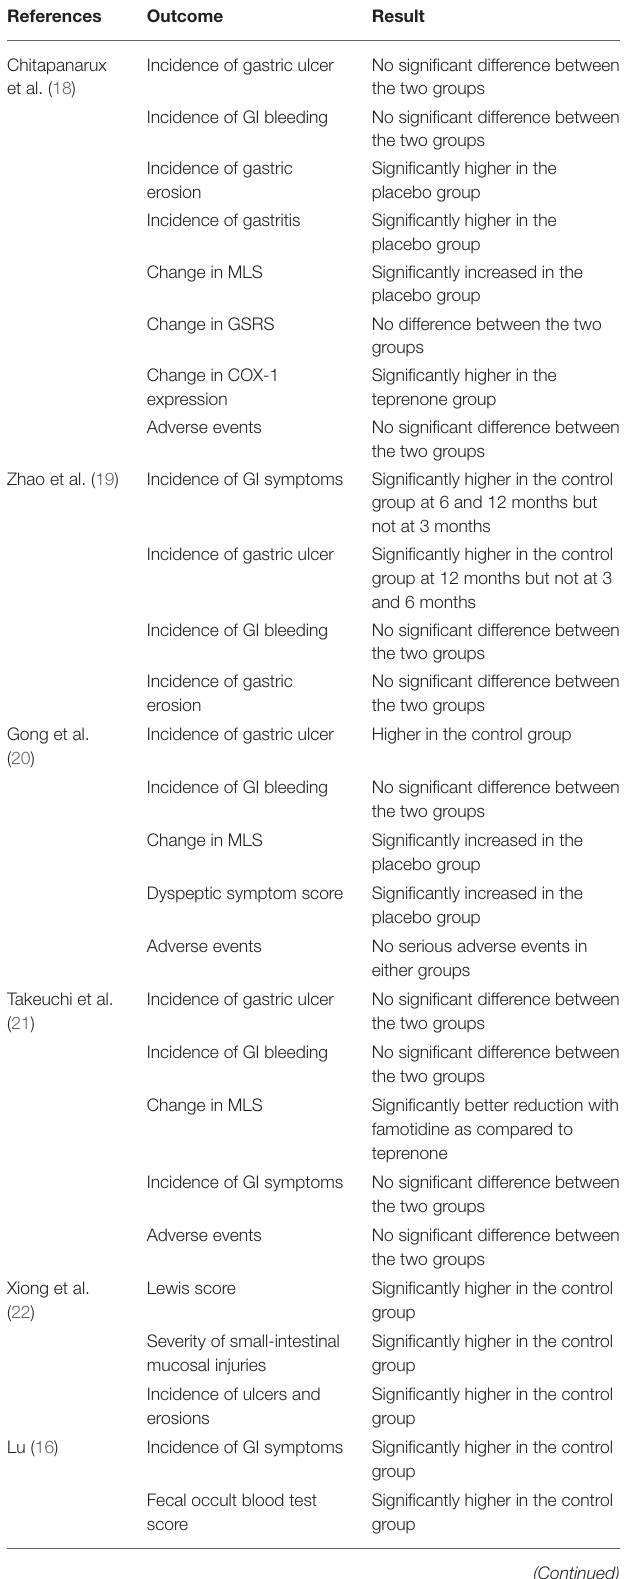
TABLE 2 | Details of outcomes and results reported by the included